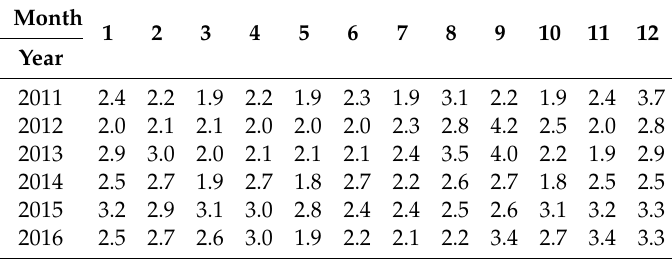
Table 2. The monthly average wind speed at Quy Nhon station from 2011–2016 (m / s). Month 1